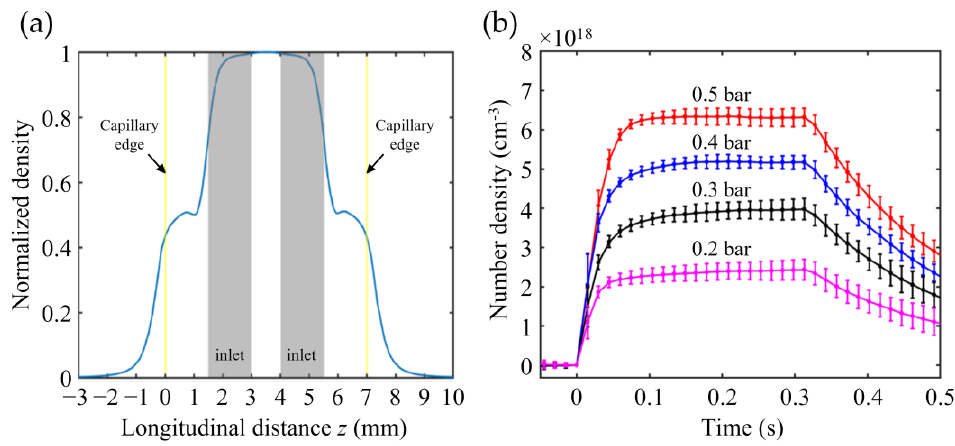
Figure 3. ( a ) CFD simulation result for the 7 mm long capillary gas cell. ( b ) Gas density temporal evolution in the capillary gas cell. The gas density was stabilized after about 50 ms of gas-filling time.